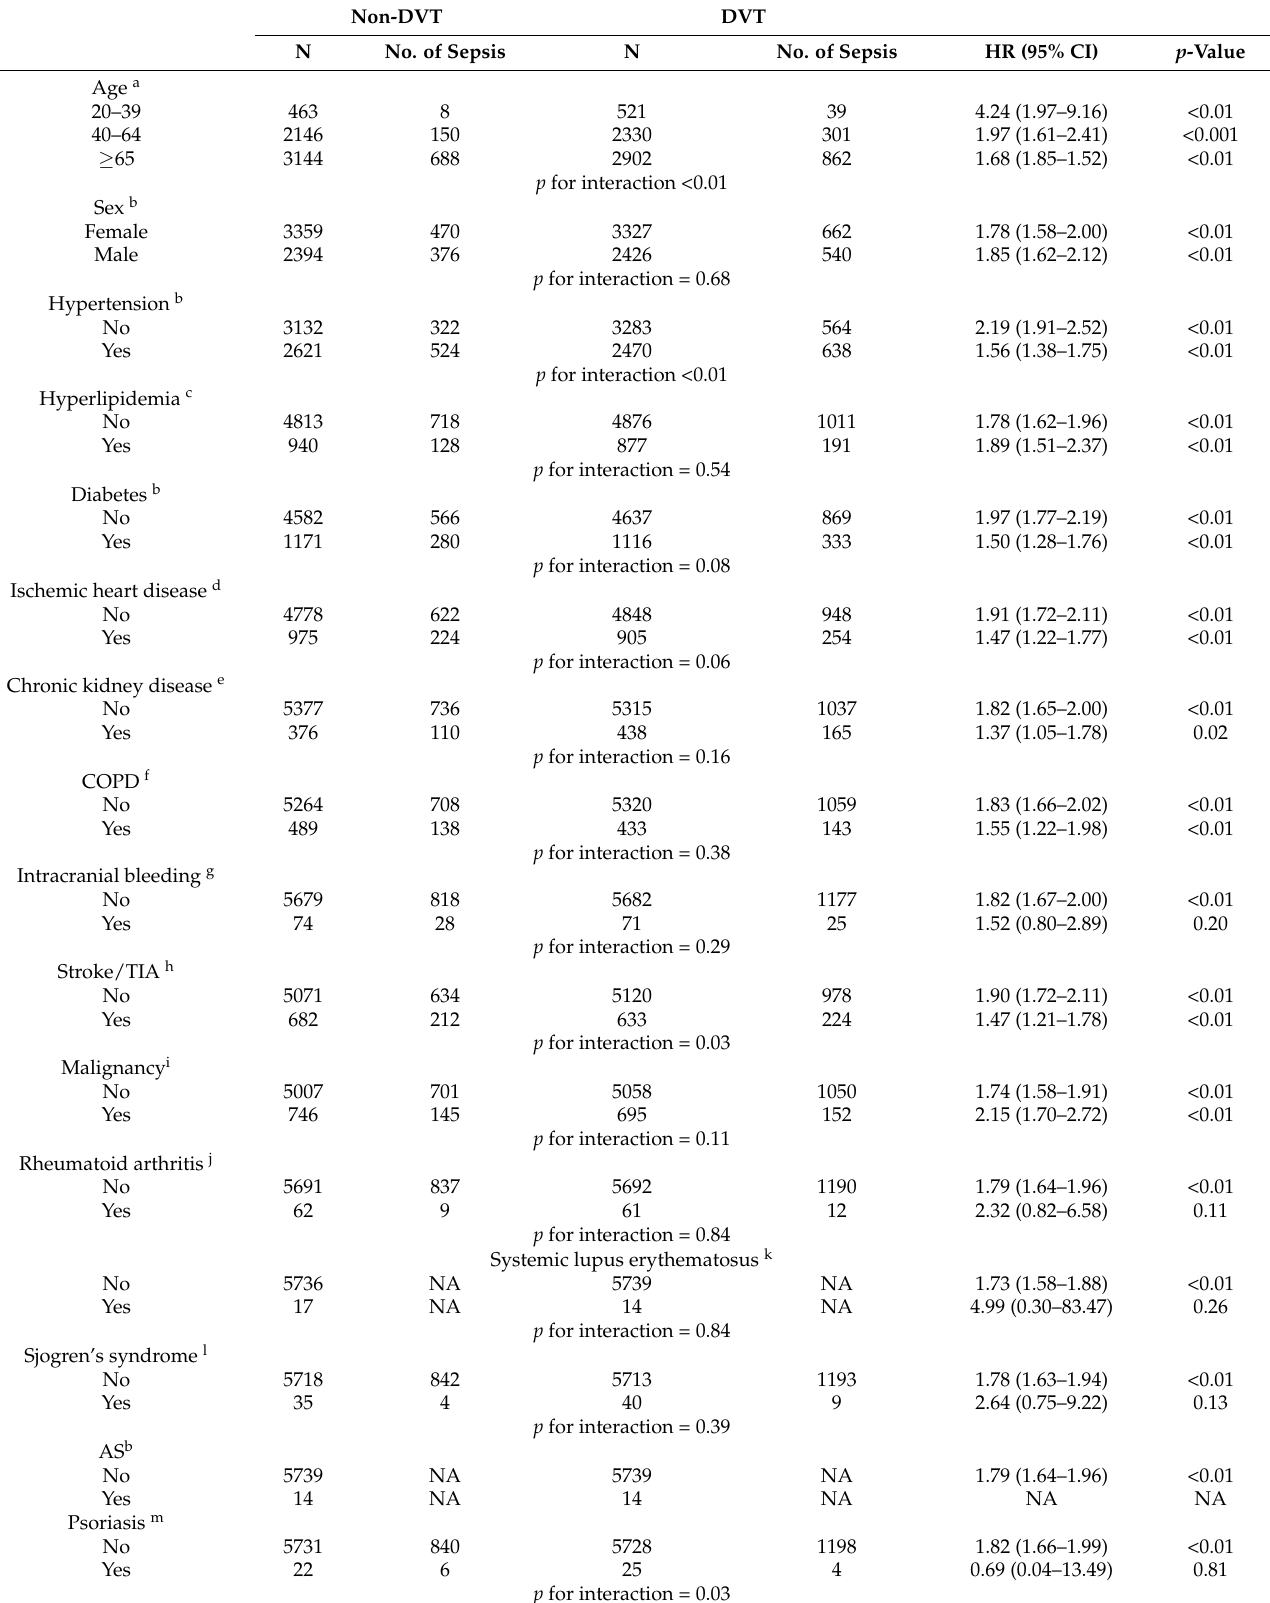
Table 4. DVT Subgroup analysis for the risks of